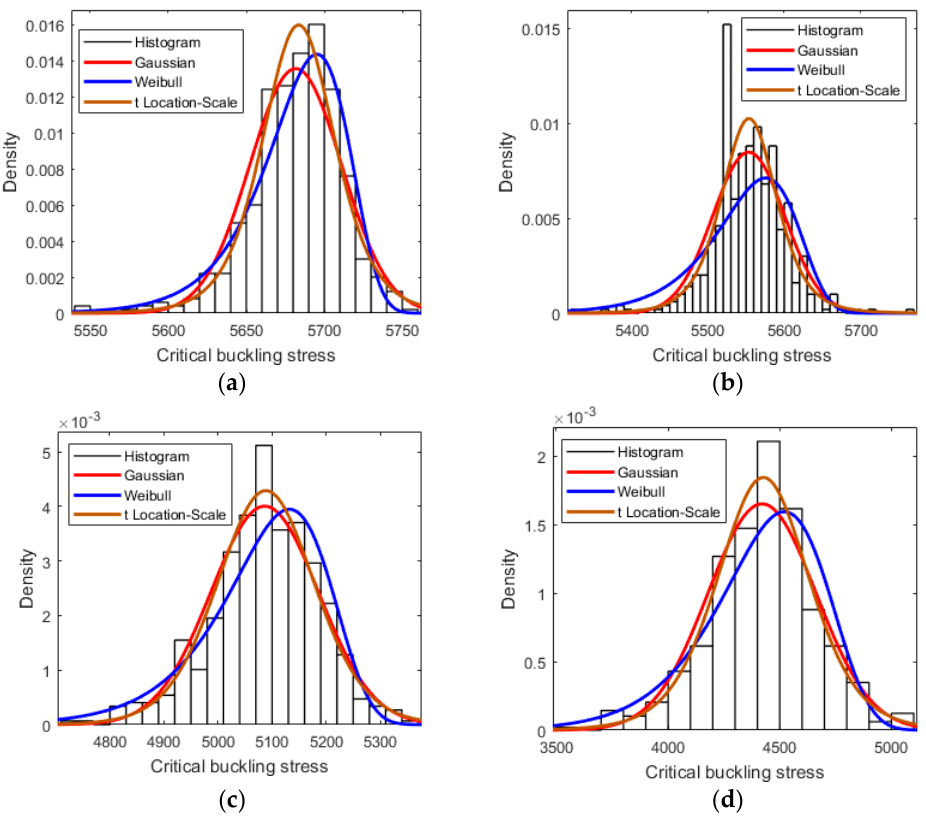
Figure 3. The probability density distribution for different amounts of vacancy defects. The samples ( a – d) represent 1%, 2%, 3%, and 4% of vacancy defects, respectively.